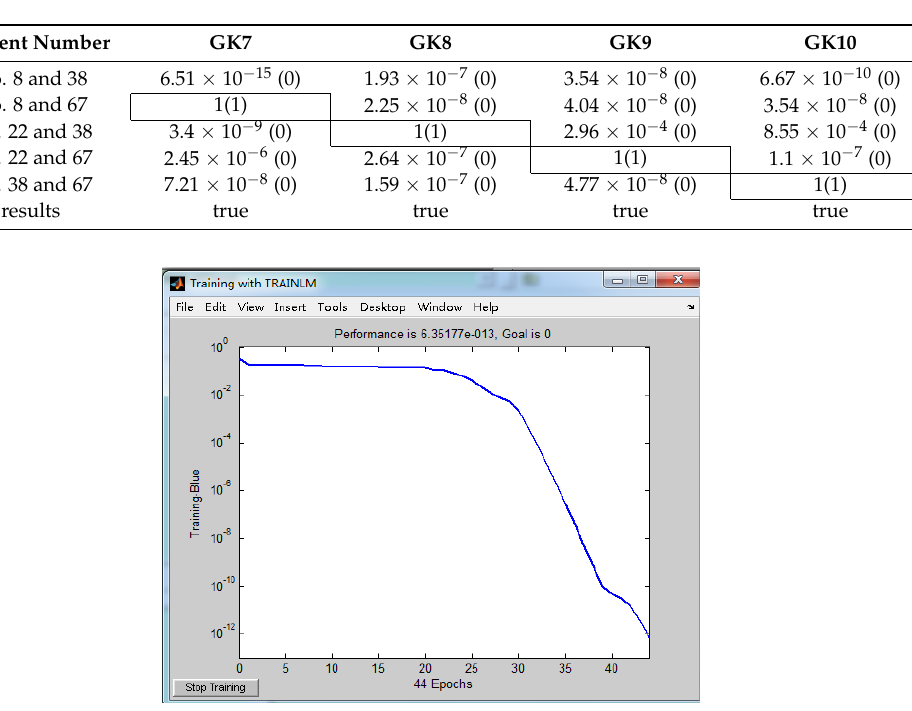
Figure 9. The training process based on the Levenberg–Marquardt (L–M) algorithm.